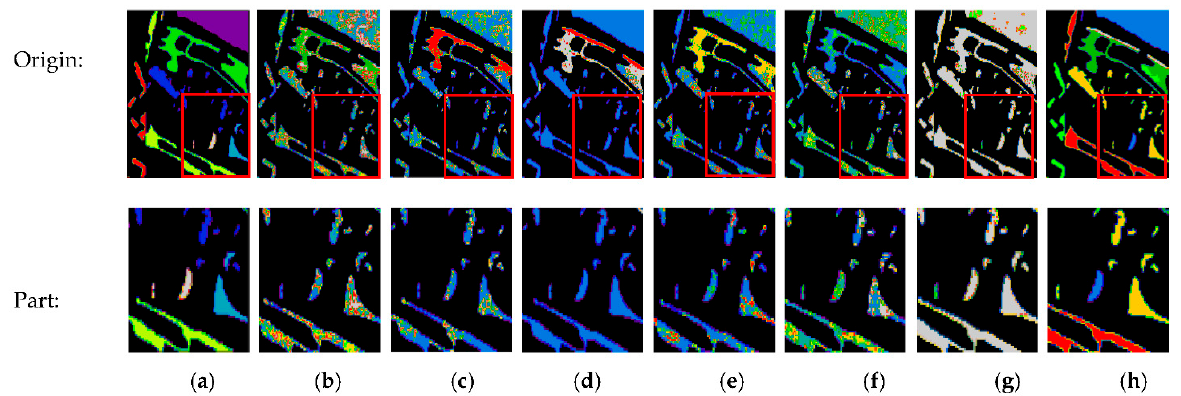
Figure 17. Clustering results obtained using different methods on the Pavia Center data set with Gaussian noise and salt and pepper noise. ( a ) Ground truth. ( b ) LRSC 34.17%. ( c ) SSC 42.89%. ( d ) S4C 47.94%. ( e ) EDSC 48.46%. ( f ) EGCSC 52.03%. ( g ) EKGCSC 31.82%. ( h ) MEKGCSC 88.72%.